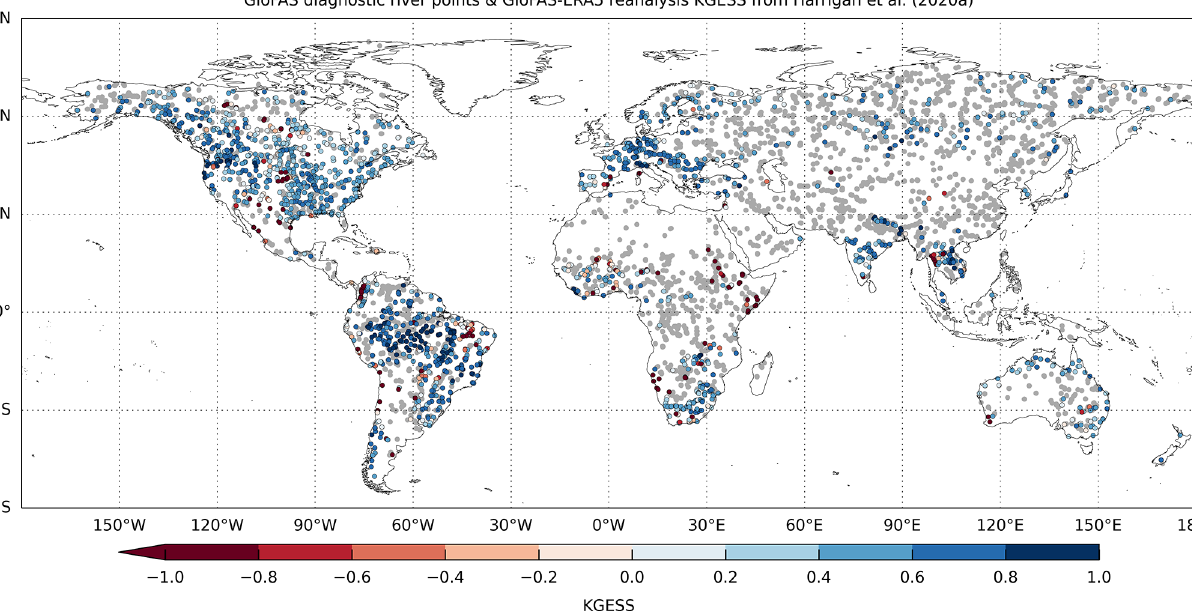
Figure 4. GloFAS diagnostic river points ( n = 5997) are highlighted by grey dots. Coloured dots show hydrological performance of GloFAS- ERA5 river discharge reanalysis against a subset of GloFAS diagnostic river points with observations ( n = 1801) from Harrigan et al. (2020a) using the modified Kling–Gupta efficiency skill score (KGESS). Optimum value of KGESS is 1. Blue (red) dots show catchments with positive (negative) hydrological